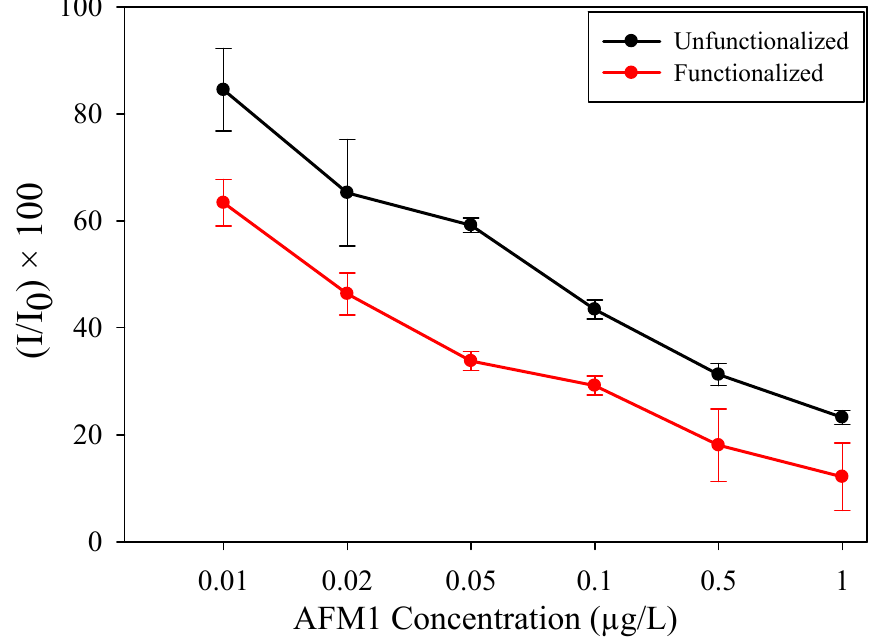
Figure 5. Chronoamperometric measurement of AFM1 in buffer solution; A 0 is the sensor response without AFM1.